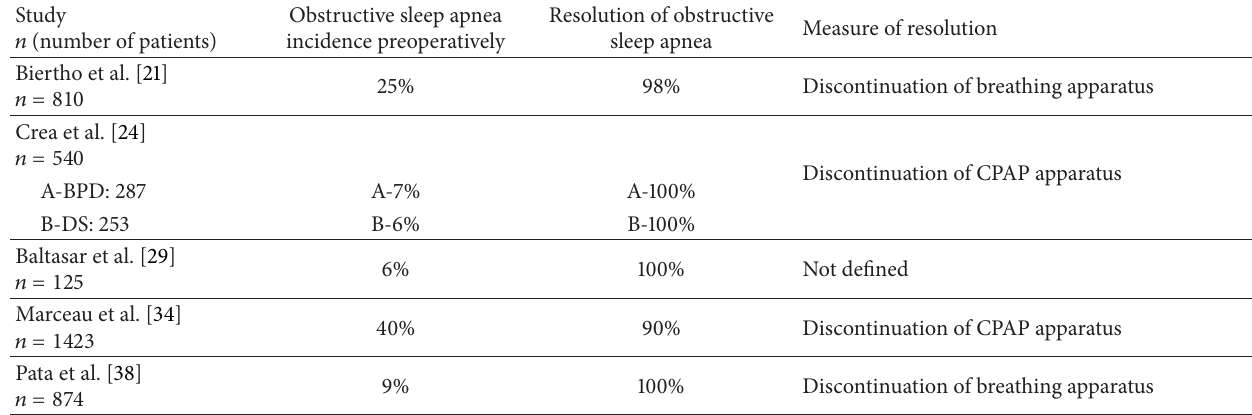
Table 4: Effect of biliopancreatic diversion with duodenal switch on obstructive sleep apnea.